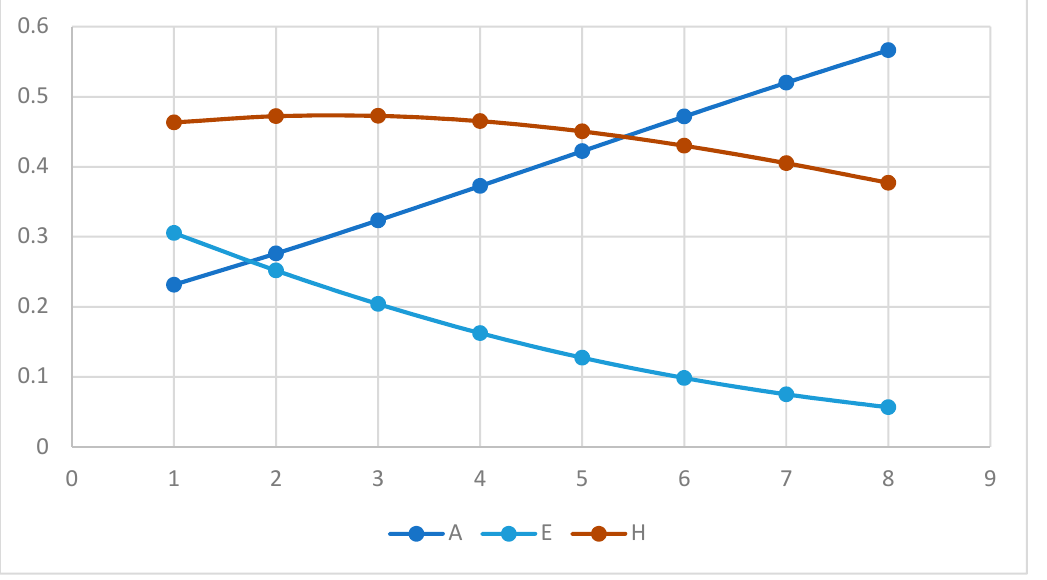
Figure 1. AHP three flavors priorities profiled by income.